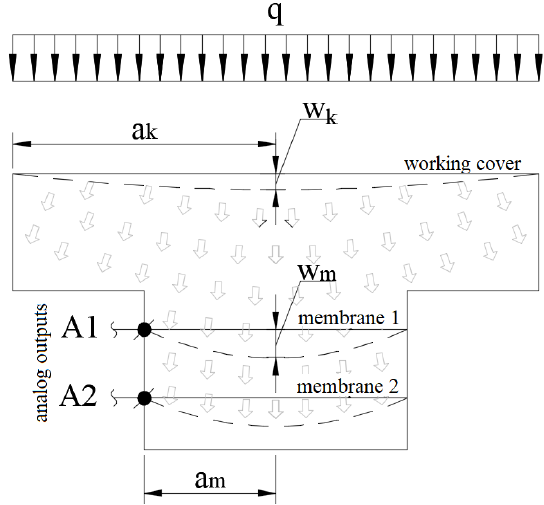
Figure 5. Functional scheme of work.